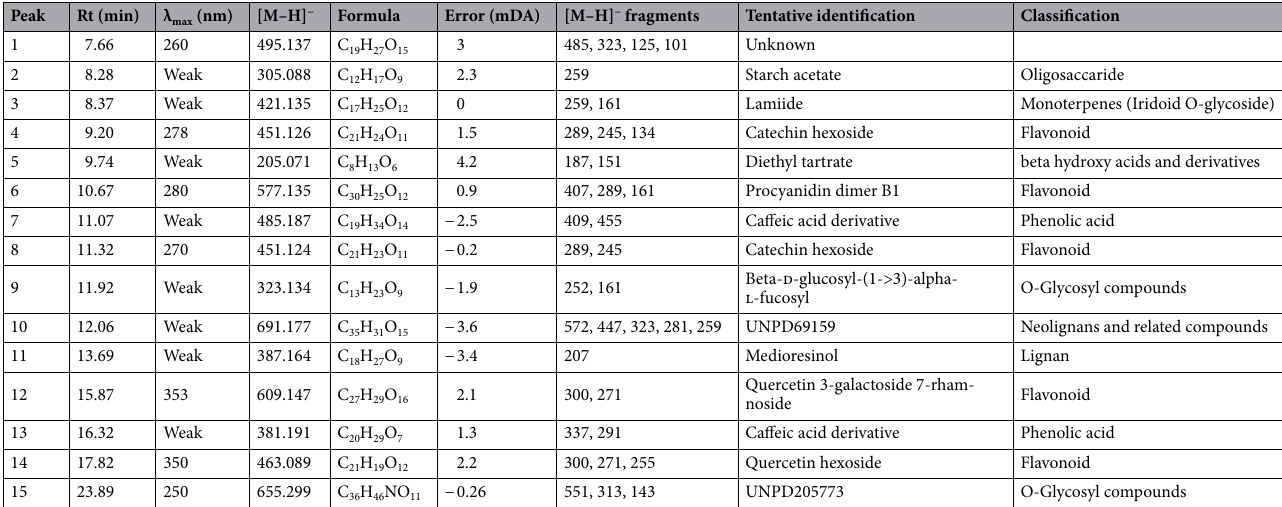
Table 2. Metabolites identified by LC–MS in negative ionisation mode present in Bambara groundnut seed methanolic extracts. Rt retention